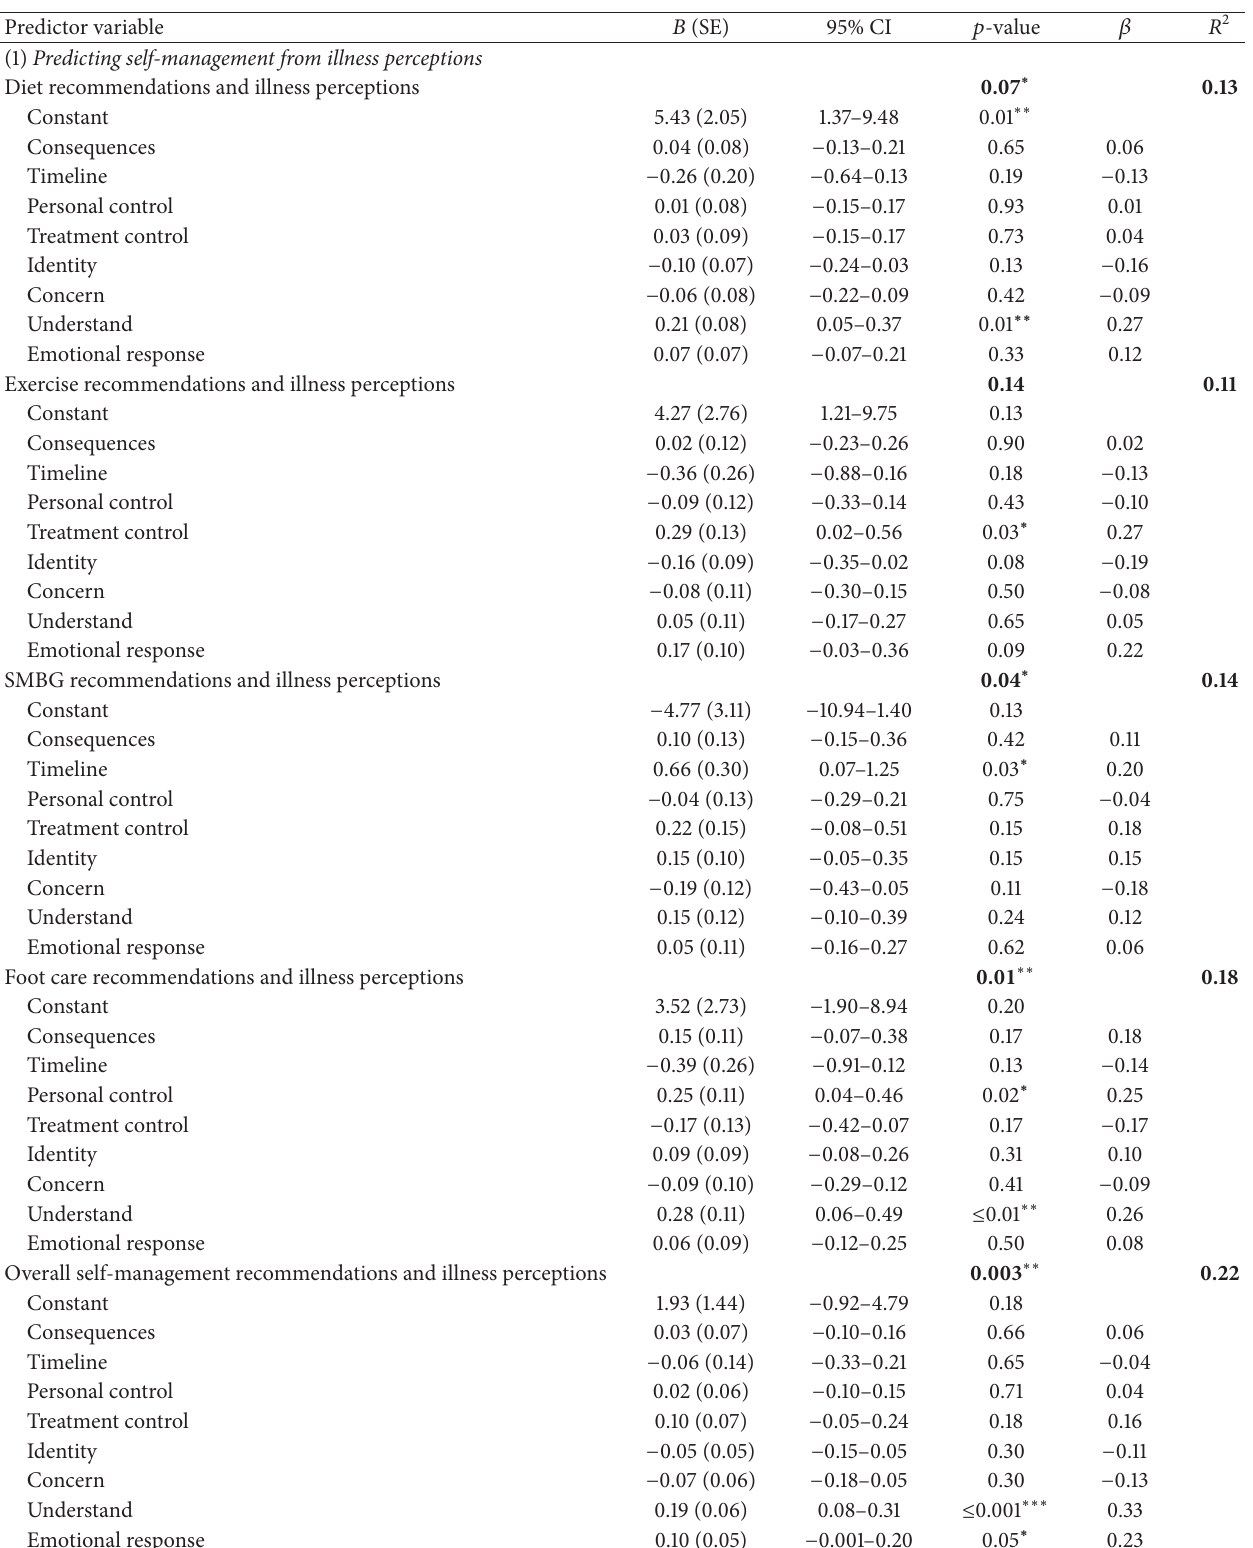
Table 3: Predicting adherence to recommended self-management behaviours from psychosocial variables (illness perceptions or self- management-related